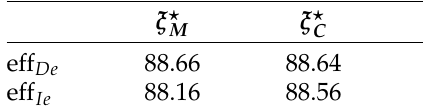
Table 4. Efficiencies of the most balanced solutions of the multi-objective algorithm ξ (cid:63) pound criterion ξ (cid:63) , for D - and I -optimality criteria in each variance structure . C